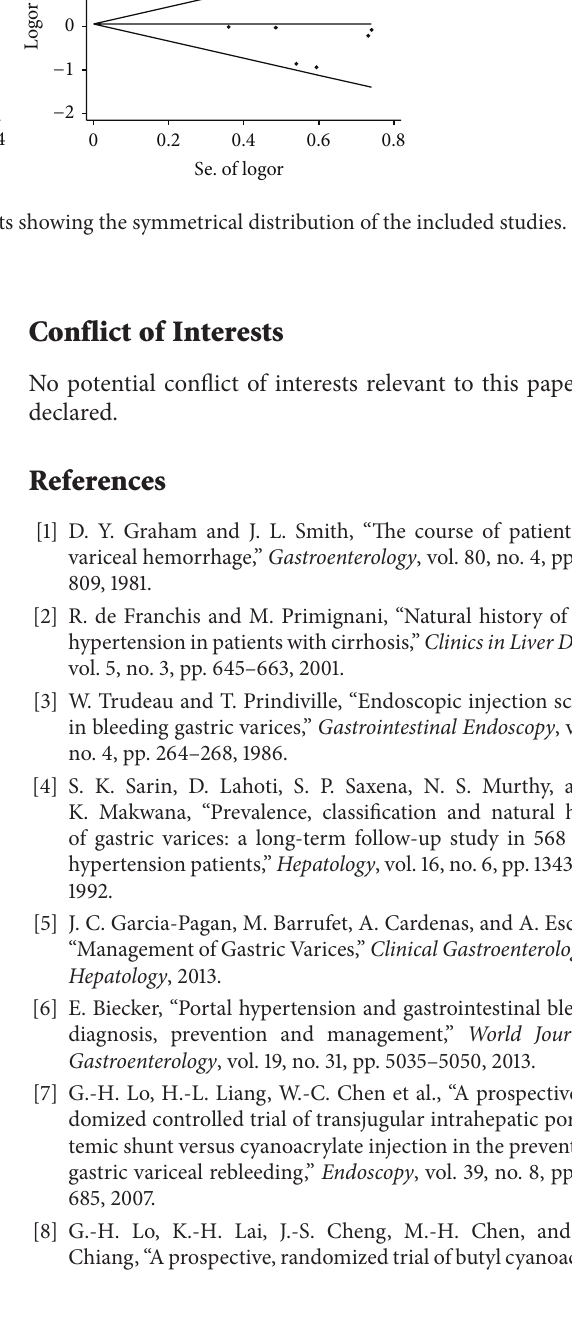
Figure 9: Begg’s funnel plot with pseudo 95% confidence limits showing the symmetrical distribution of the included studies.